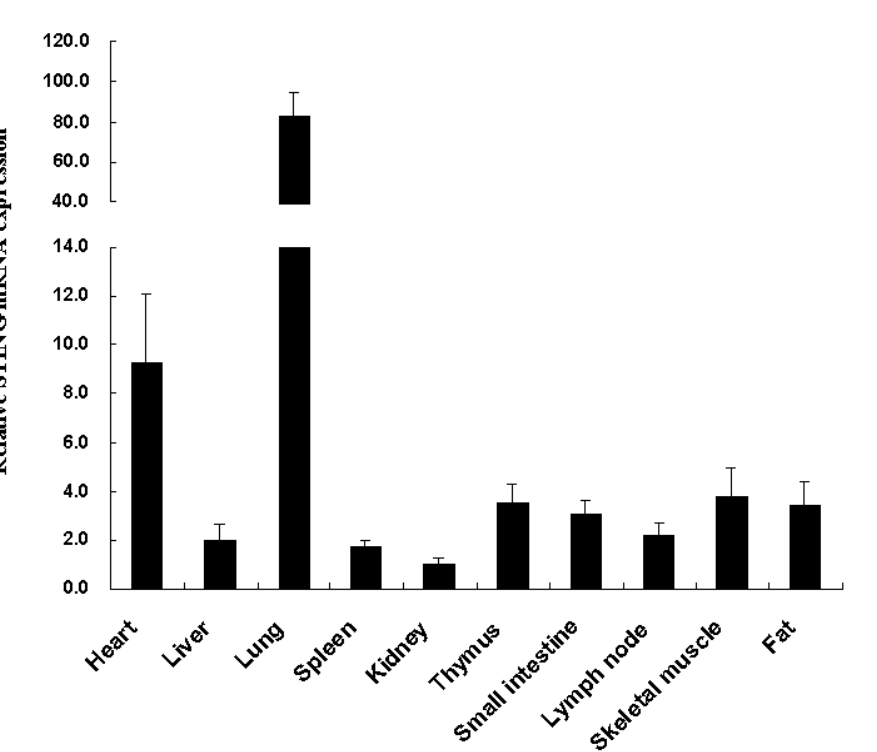
Figure 2. Relative mRNA expression of Tibetan porcine STING in different tissues. Total RNA from different tissues of 3 healthy Tibetan pigs was used to perform the real-time quantitative PCR. Samples were performed in duplicate. The amount of Tibetan porcine STING mRNA was normalized to the amount of β-actin mRNA. Data are presented as mean ± SE ( n = 3), in arbitrary